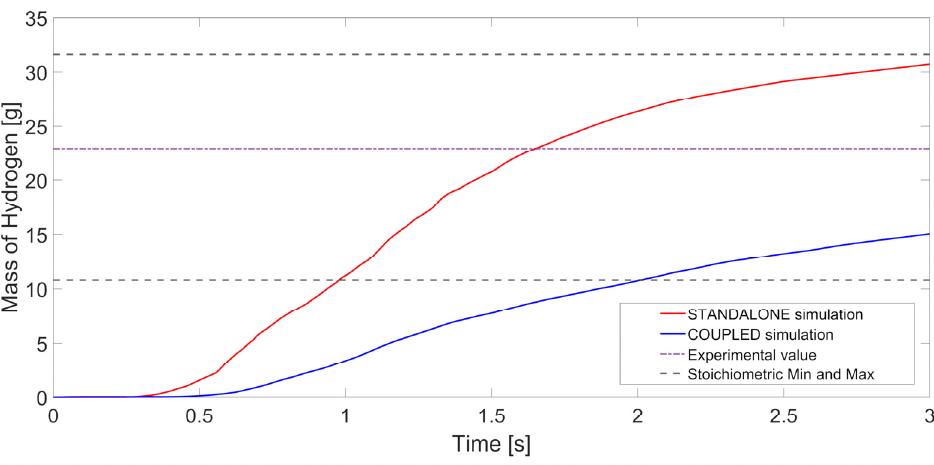
Figure 20. Standalone and Coupled simulations—total mass of liquid water injected in S1B.